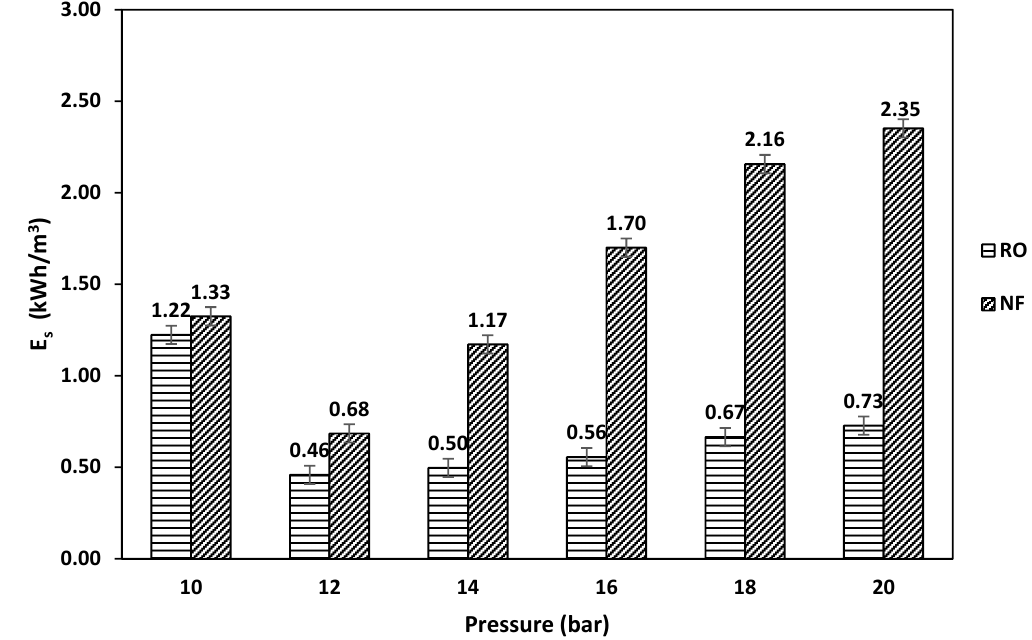
Figure 5. Specific energy consumption of RO and NF at different feed pressures.